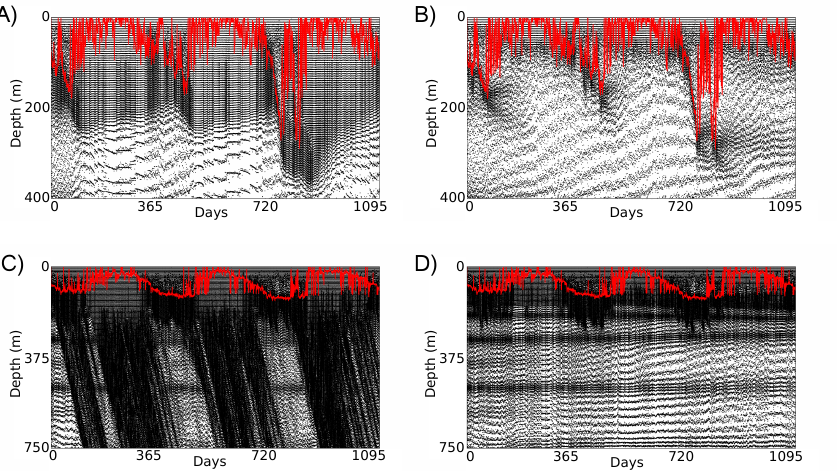
Fig. 17. Comparison of meshes produced by adaptive simulations. (A) Bermuda with the addition of chlorophyll to the adaptivity metric, (B) the original adaptive simulation at Bermuda using velocity, density and nutrients. Similarly, for Station Papa: (C) adaptive simulation with detritus included in the metric and (D) original adaptive simulation